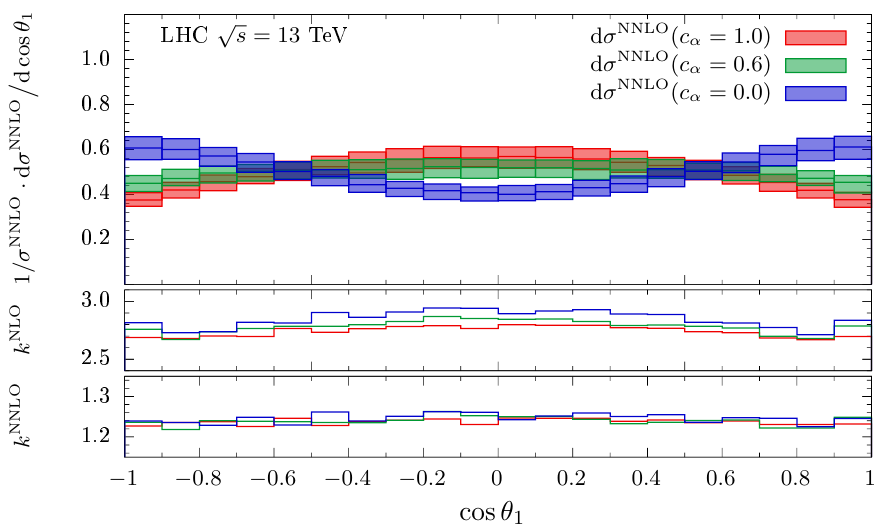
Figure 2 . Normalized distribution at NNLO accuracy and di(cid:11)erential k -factors d k NLO and d k NNLO for the cos (cid:18) 1 observable. See text for further